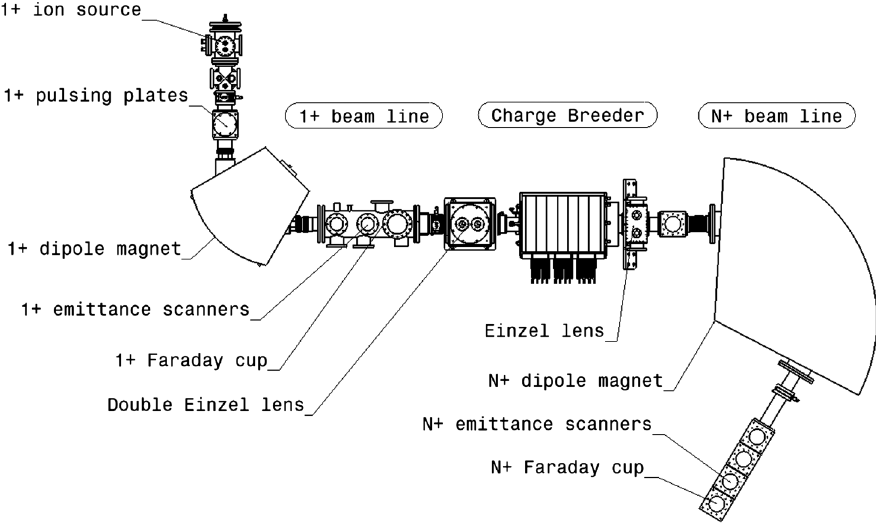
FIG. 2. Schematic layout of the 1 þ → N þ test